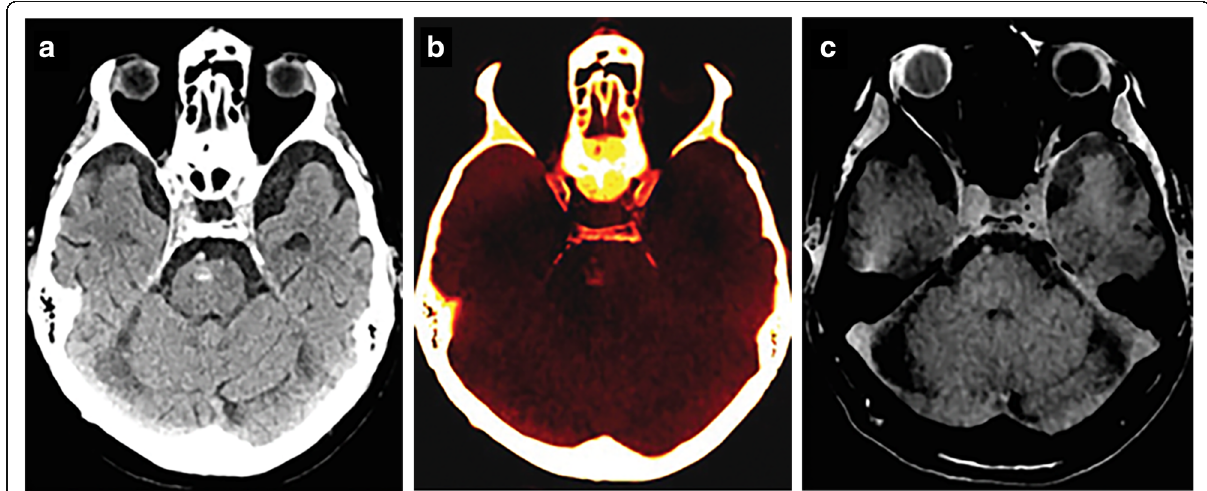
Fig. 1 Head dual-energy computed tomography scan shows a focal hyperattenuation in the pons classified as indeterminate at standard grayscale series ( a ). This 80-year-old patient with a history of hypertension presented to the emergency department with altered mental status. On the calcium-overlay image ( b ), the hyperattenuation focus remains visible, while it is not apparent on the virtual non-calcium image ( c ), suggestive for parenchymal calcification. The finding was confirmed by magnetic resonance imaging. From Hu et al.